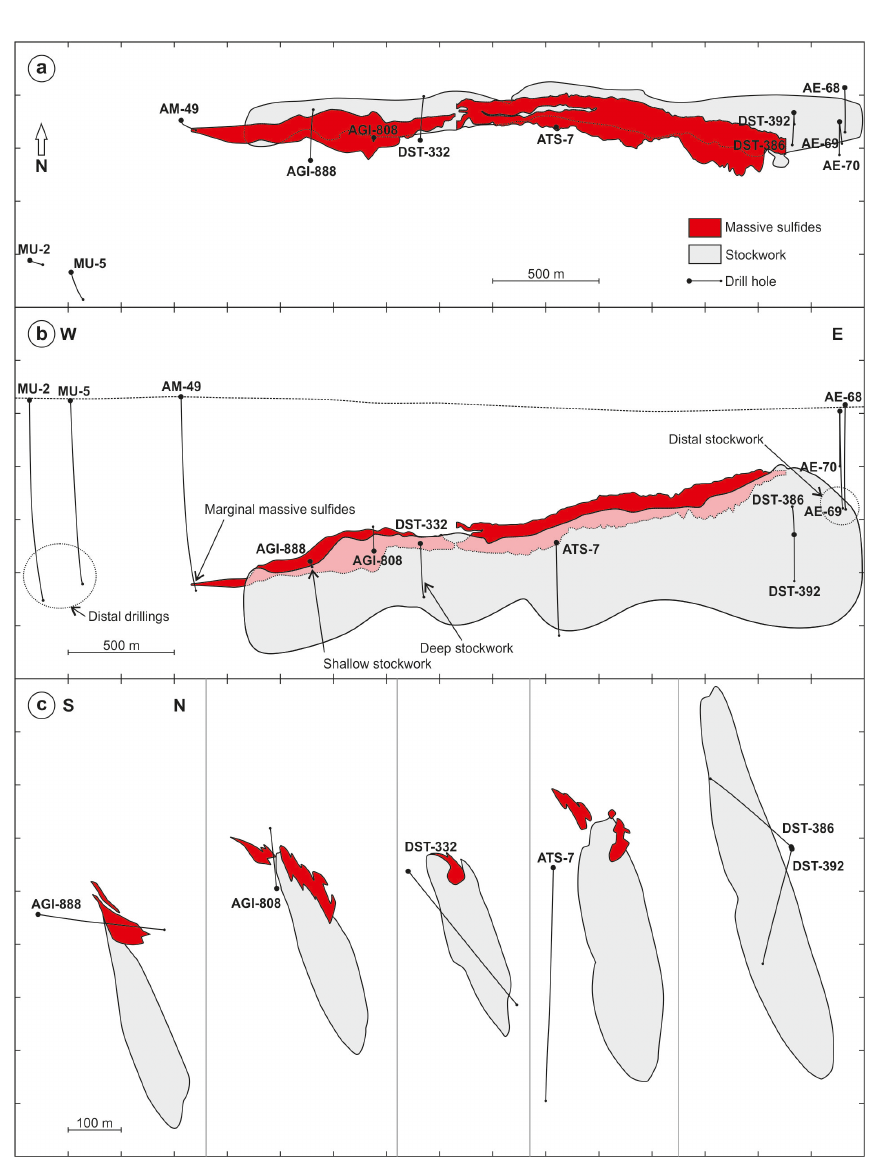
Figure 3. Plan view (a) , front view (b) , and cross sections perpendicular to the deposit elongation (c) of the Aguas Teñidas deposit (massive sulfides and stockwork) and the location of the studied drill holes. The front view (b) is facing N with no vertical exaggeration; the dotted line represents the ground level. Cross sections (c) are facing W with no vertical exaggeration. Data provided by MATSA (Mina de Aguas Teñidas